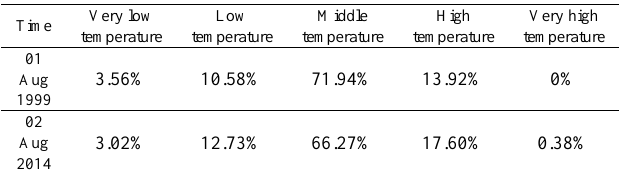
Table 3. the percentage of the area of each of the classes of surface temperature in Tehran